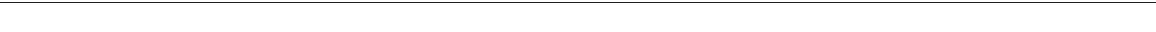
Fig. 1 Histone chaperone ASF1A is physically associated with USP52. a Immunoaf fi nity puri fi cation and mass spectrometry analysis of ASF1A-containing protein complexes. MCF-7 cells allow doxycycline (Dox)-inducible expression of stably integrated FLAG-ASF1A was generated. Whole-cell extracts from MCF-7 cells with or without FLAG-ASF1A expression were prepared and subjected to af fi nity puri fi cation using an anti-FLAG af fi nity column. After extensive washing, the bound proteins were eluted with excess FLAG peptides, resolved, and then visualized by silver staining on SDS-PAGE. The protein bands on the gel were recovered by trypsinization and analyzed by mass spectrometry. Detailed results from the mass spectrometric analysis are provided as Supplementary Data 1. b Whole-cell lysates from HeLa or MCF-7 cells were immunoprecipitated (IP) followed by immunoblotting (IB) with antibodies against the indicated proteins. c ASF1A-containing protein complex puri fi ed from HeLa cells stably expressing FLAG-ASF1A was fractionated by fast protein liquid chromatography (FPLC) on Superose 6 size exclusion columns with high salt buffer. Chromatographic elution pro fi les and IB analysis of the chromatographic fractions with antibodies against the indicated proteins are shown. The elution positions of calibration proteins with known molecular masses are indicated, and an equal volume from each fraction was analyzed. d Co-immunoprecipitation analysis of the interaction between USP52 and ASF1A with cellular lysates from different cellular compartments of MCF-7 cells. e Immunostaining and confocal microscopy analysis of USP52 and ASF1A subcellular localization in MCF-7 cells. Scale bar, 10 μ m. f Co-immunoprecipitation analysis of the molecular interface between ASF1A and USP52 with cellular lysates from HeLa cells expressing FLAG-GFP tagged full length or deletions of USP52. The conserved domain of USP52 was determined by the SMART program. WD40: WD40 repeat domain, UCH: ubiquitin C-terminal hydrolase domain, EXO: exonuclease domain. g Co-immunoprecipitation analysis of the molecular interface between ASF1A and USP52 with cellular lysates from HeLa cells expressing FLAG-tagged full length or deletions